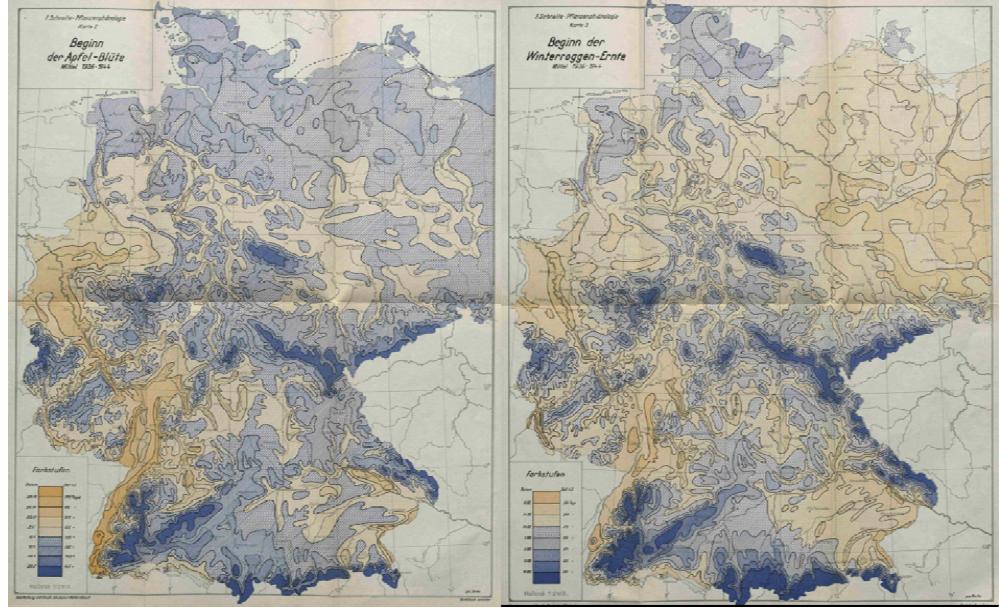
Fig. 2. Start of flowering of apple trees (left); begin of winter rye harvest (right) between 1936 and 1944 in Germany (1:2’000’000) by Schnelle (1955).